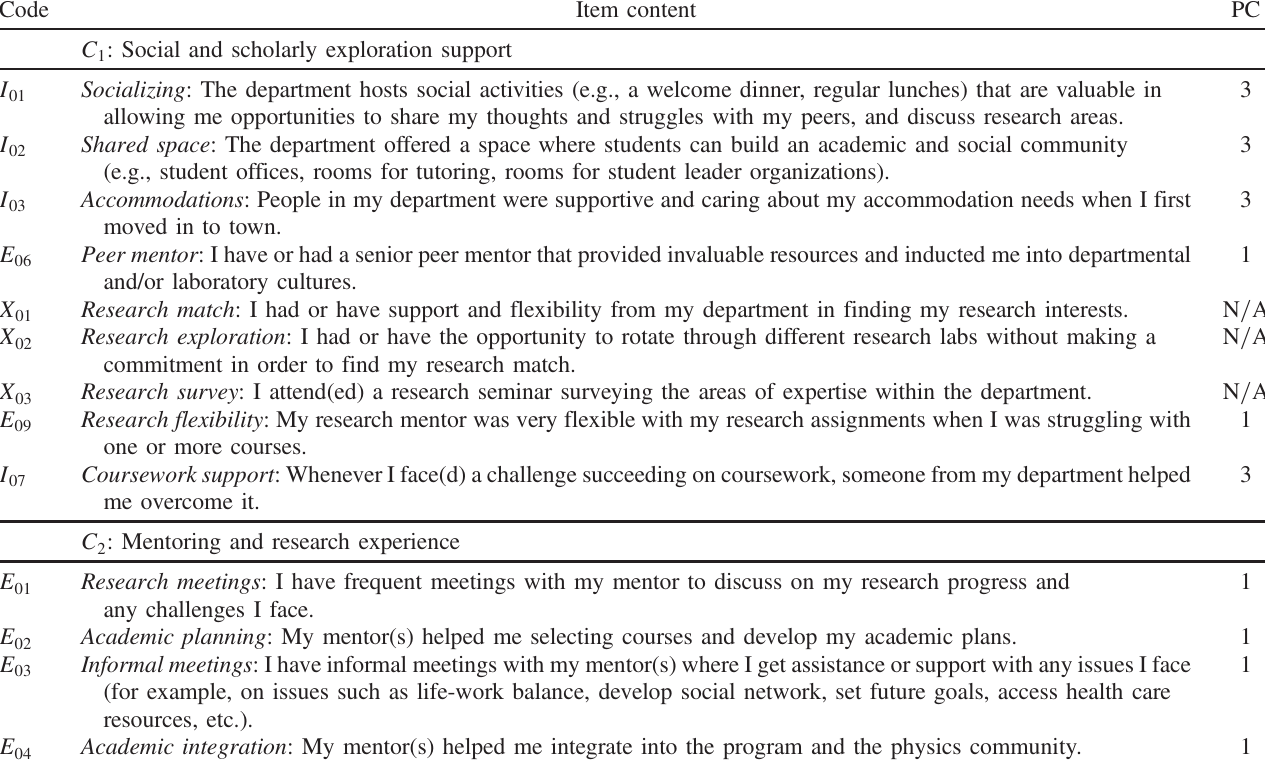
TABLE II. Cluster membership from the fast-greedy cluster algorithm. The first column indicates the question code while the second gives the item description, along with a shorthand name. The component assignment, PC, is given in the last column. Code Item content